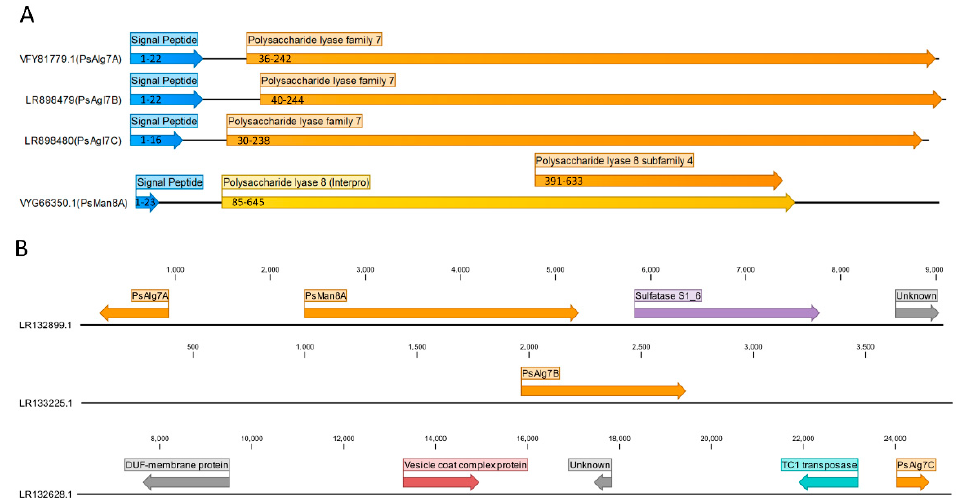
Figure 1. ( A ) HMM-based domain architecture of the four alginate lyase protein sequences. Signal peptides were predicted by Phobius (blue) and the catalytic domains by HMMer using dbCAN models (orange) and the Interproserver (yellow). The numbers indicate the location of the predicted domain on the full length sequence. ( B ) Contig-based genetic environment of the lyases. The contig accession numbers from GenBank are displayed in front of each sequence. The predicted genes, annotation, and transcription direction are represented by the colored arrows. The number-scale on each contig represents the nucleotide count.